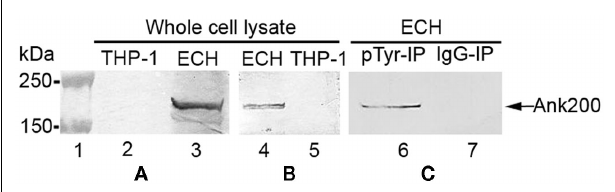
FIGURE 4 | E. chaffeensis Ank200 protein was tyrosine phosphorylated in infectedTHP-1 cells. Whole cell lysates from normal (THP-1) and E. chaffeensis -infectedTHP-1 cells (ECH) were prepared and probed with (A) anti-pTyr antibody (lanes 2 and 3), (B) anti-Ank200 (lanes 4 and 5). (C) ECH whole cell lysates immunoprecipitated with mouse anti-pTyr antibody (pTyr-IP, lane 6) or normal mouse IgG (IgG-IP, lane 7) and detected with Ank200